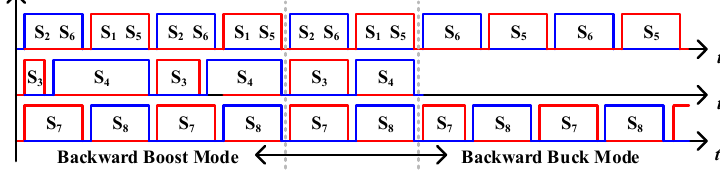
Figure 5. The drive signal during mode switching.